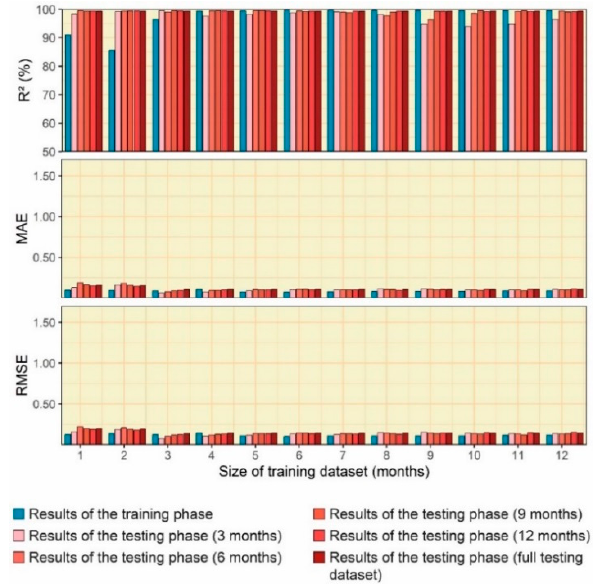
Figure 8. Influence of the size of the training sample on the MLR model (approach 1).